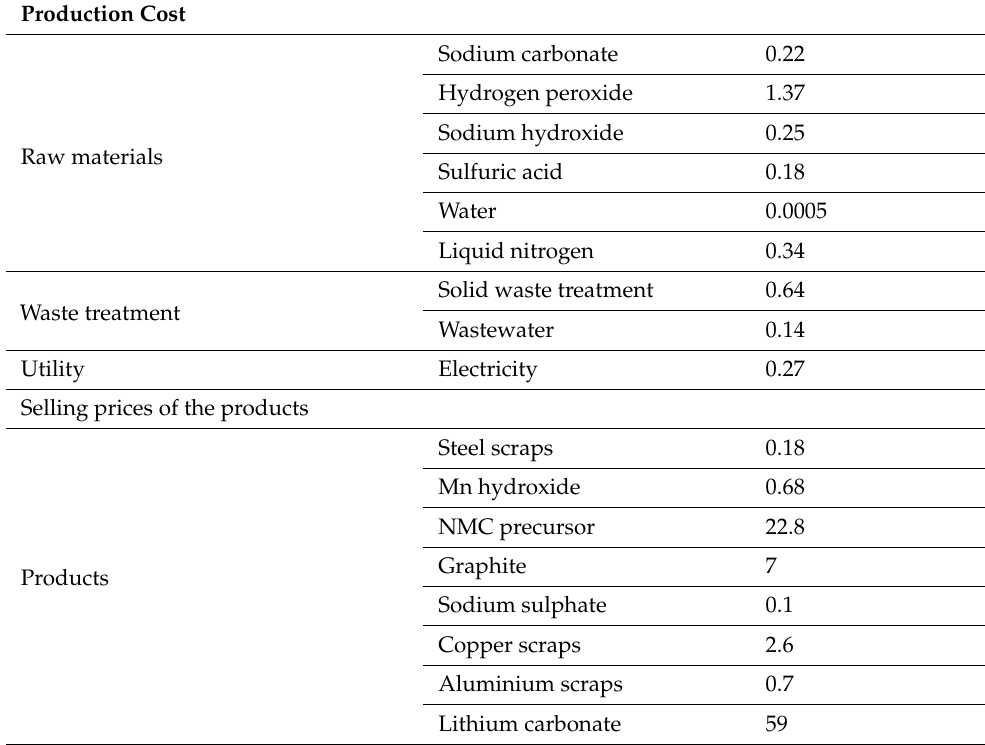
Table A2. Costs of raw materials (EUR/kg), utilities (EUR/kWh), and waste treatment (EUR/kg), and the selling prices (EUR/kg) of the products